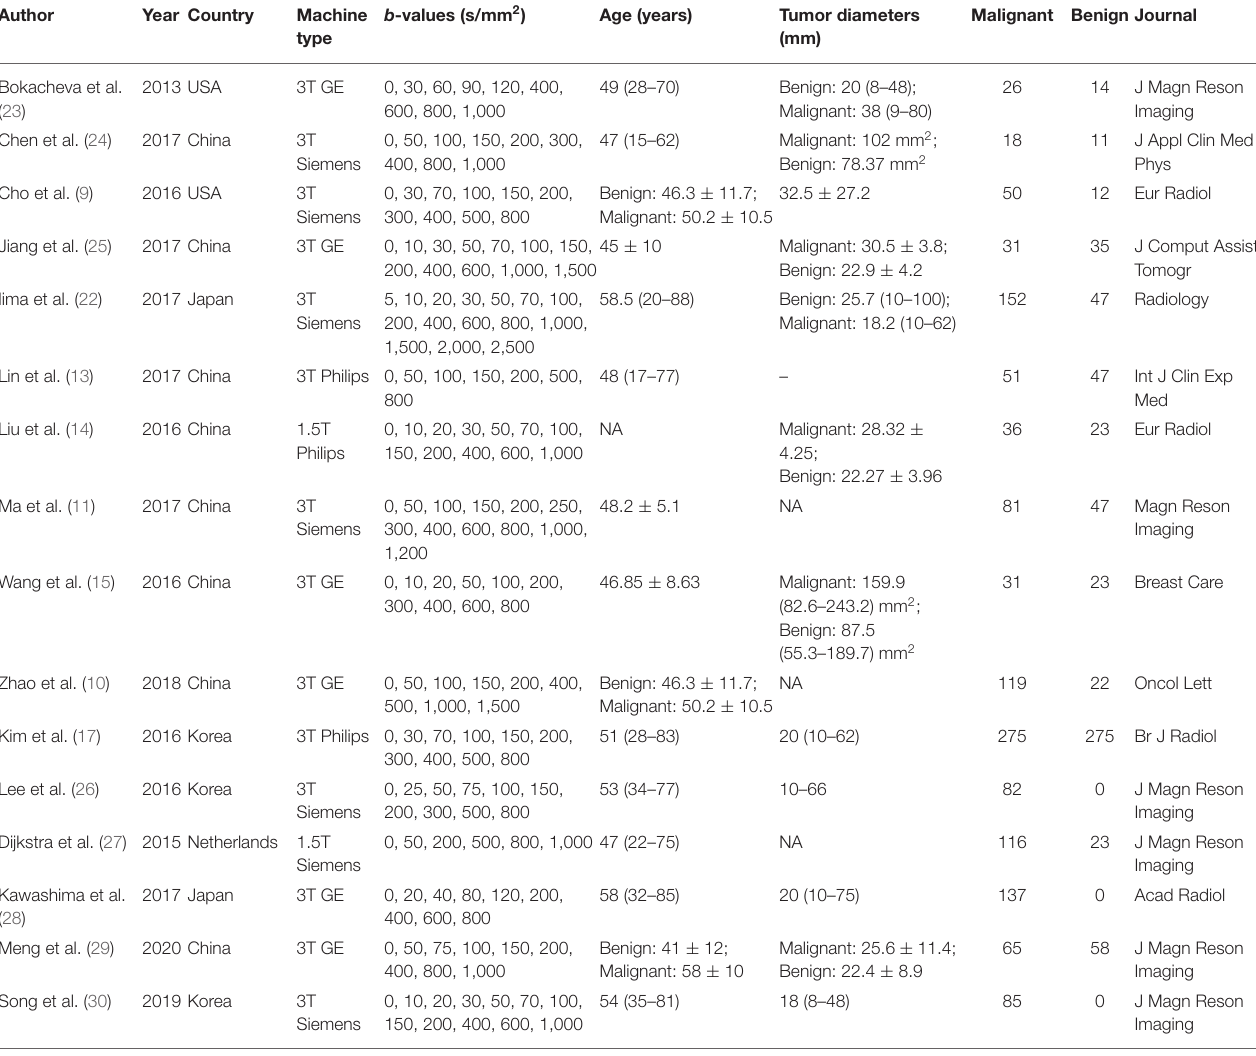
TABLE 1 | Basic information from each included